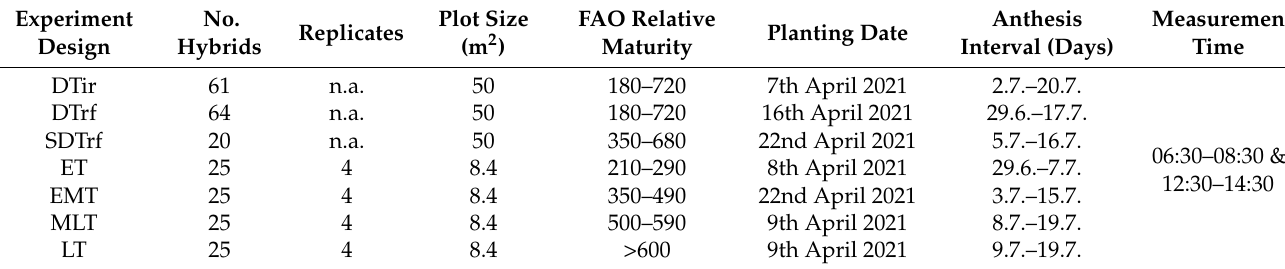
Table 1. Details about experimental